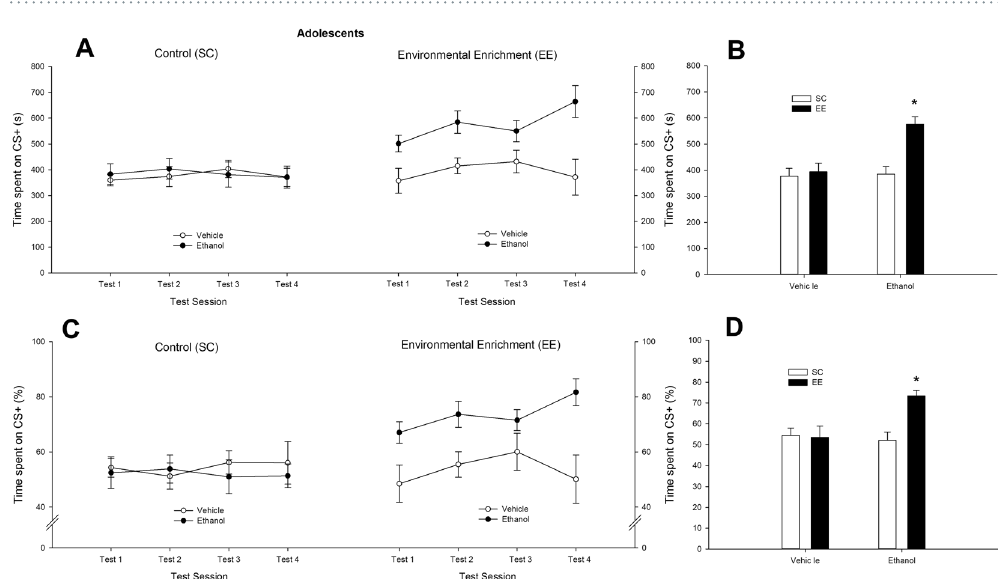
Figure 2. Ethanol-induced conditioned place preference (CPP) in adolescent male Swiss mice, at test sessions 1, 2, 3 and 4. The line graphs depict time spent (in seconds or in percent preference, sections ( A ) and ( C ), respectively) in the chamber associated with ethanol’s effects (conditioned stimulus [CS + ]), as a function of rearing condition (standard [control] conditions and environmental enrichment; SC and EE groups, respectively) and treatment during CPP training (vehicle or 2.0 g/kg ethanol). The small bar graphs ( B and D ) depict absolute (s) and percent time spent in the CS + collapsed across test sessions. Animals that were given ethanol and were reared under EE conditions spent significantly more time in the chamber associated with ethanol than the rest of the animals that were treated with vehicle or ethanol, an effect that was statistically similar across test sessions. This significant effect is indicated by the asterisk sign. Values express mean ±